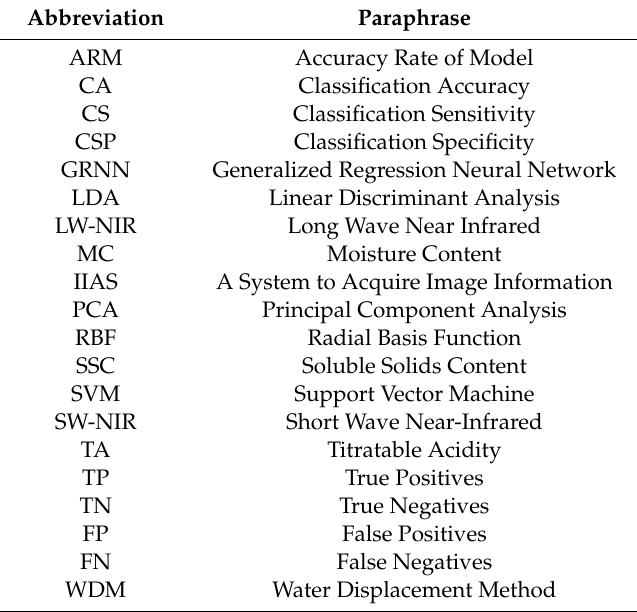
Table A1. Definitions of abbreviations used in the